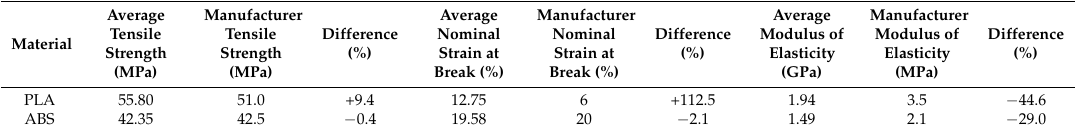
Table 3. The comparison of mechanical properties (laboratory vs. manufacturer).